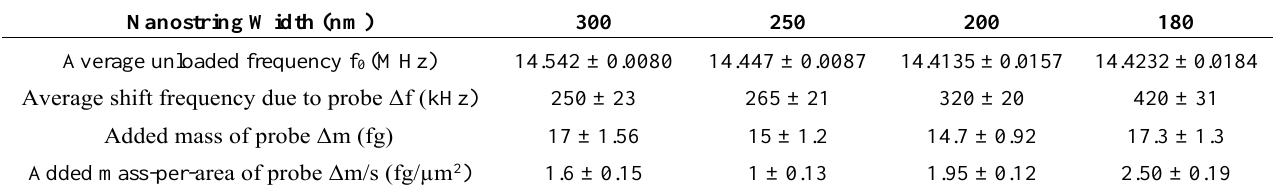
Table 1. Analysis of average resonant frequency shift and added mass of the resonator array of sample A due to the attachment of aryl film, anti-rabbit IgG and BSA.